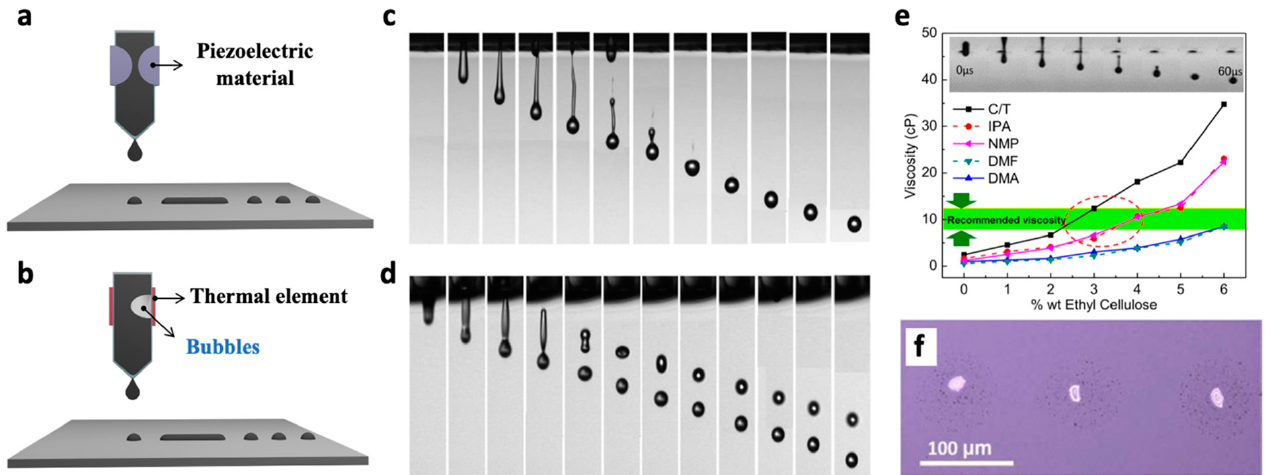
Figure 6. Schematics of DoD inkjet printing with ( a ) piezoelectric and ( b ) thermal head. Representative photo sequence of drop formation for fluids with ( c ) Z = 4.08 and ( d ) Z = 13.68 at a constant driving voltage of 25 V. Reprinted with permission from Ref. [56]. Copyright 2009 American Chemical Society. ( e ) Graph showing the change in viscosity of the five solvents with the addition of EC and area of recommended viscosity values for inkjet printing. Inset shows successful drop formation and ejection from the printer nozzle with minimal satellite droplets. Reprinted with permission from Ref. [41]. Copyright 2016 IOP Publishing. ( f ) Graphene line obtained with a water based ink with Z ≈ 20 and excess surfactant which aggregates in the centre of the dots. Reprinted with permission from Ref. [7]. Copyright 2017 Springer Nature.